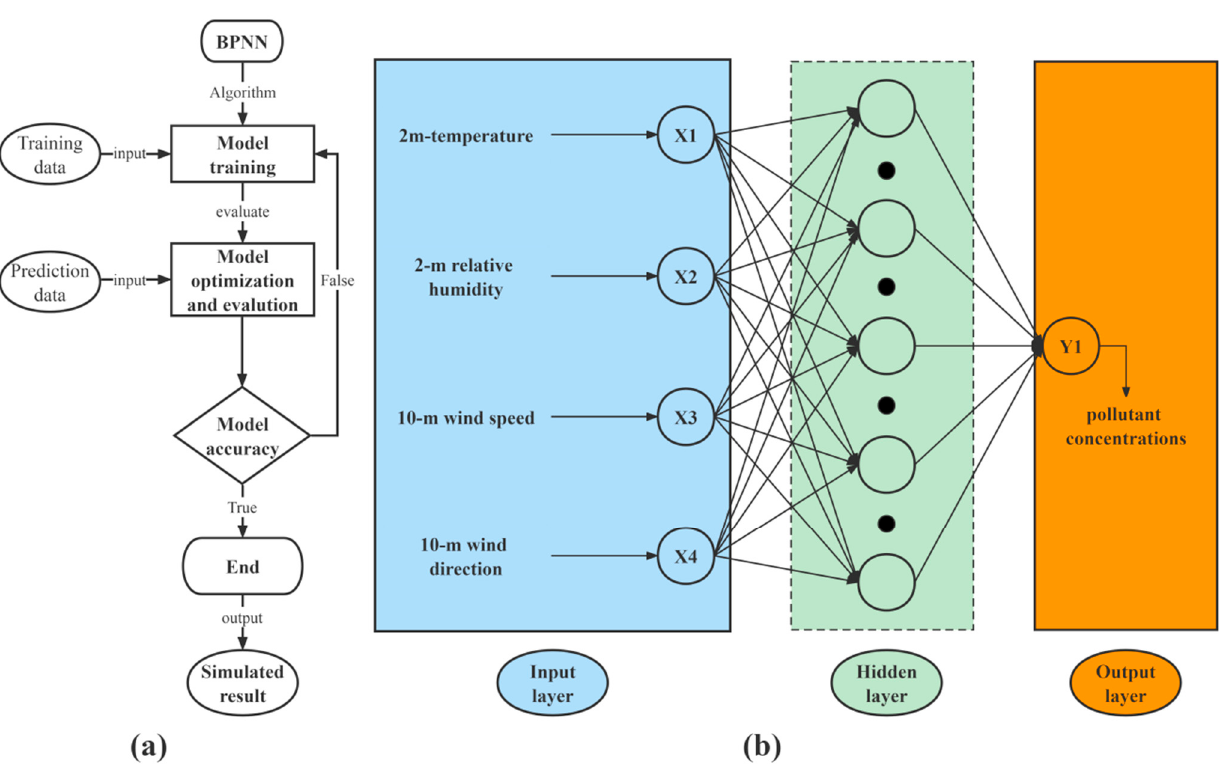
Figure 4. Schematic of the ( a ) back propagation neural network (BPNN) and ( b ) structure of the BPNN used to simulate pollutant concentrations in Guangzhou.